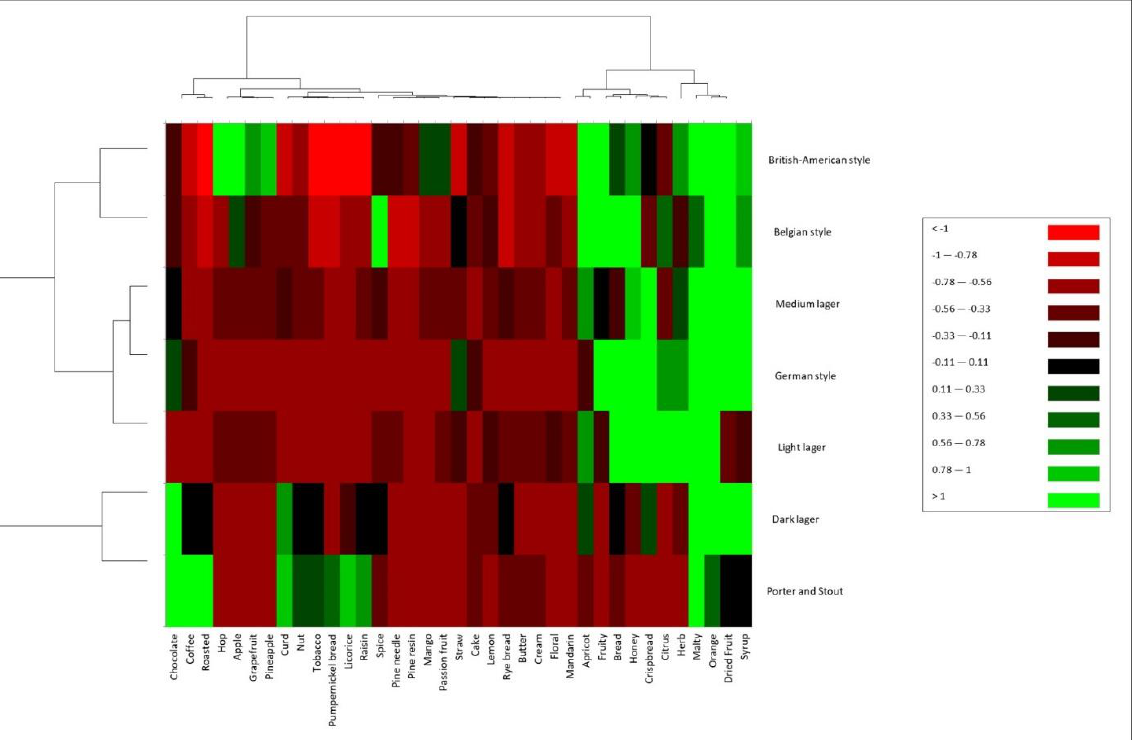
Figure 4. Heatmap illustrating the sensory attributes and beer styles. The dendrogram on the left corresponds to the hierarchical cluster analysis (HCA).